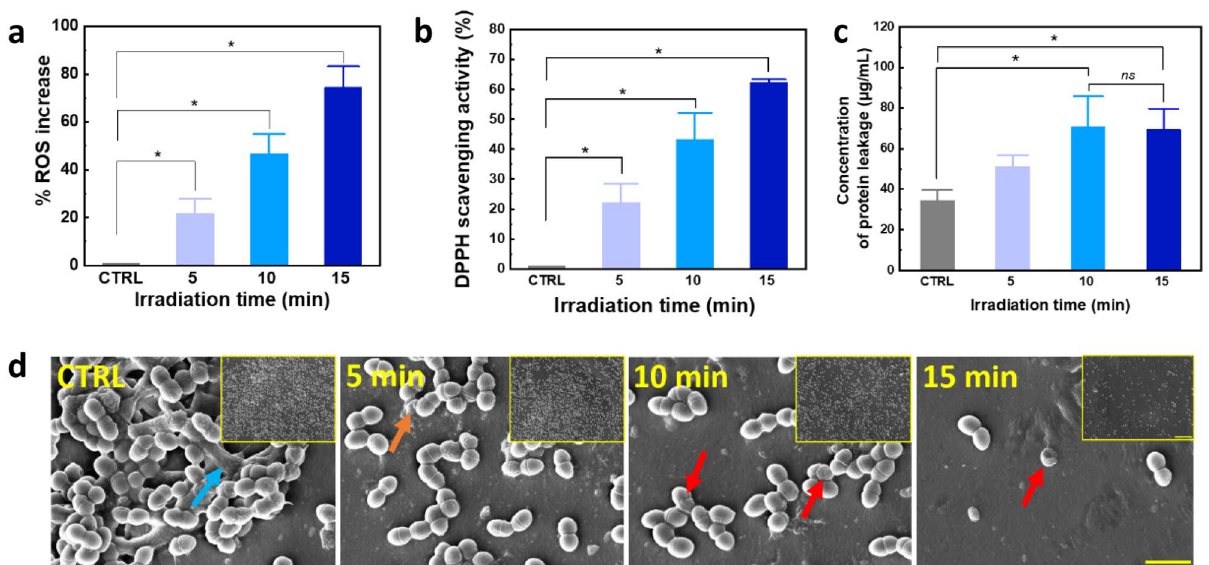
Figure 5. Optical inhibition effect of 405 nm laser light against S. aureus in urethral stent: ( a ) ROS generation during treatment, ( b ) DPPH scavenging activity, and ( c ) concentration of protein leakage using Lowry method ( * p < 0.05 and ** p < 0.001 vs. CTRL; ns = not significant; N = 5), and ( d ) SEM images of S. aureus after laser treatment (blue, orange, and red arrow represent thick biofilm, bacteria released from biofilm, and bacterial death with morphological damage (scale bar = 2 µm; 20 kX and scale bar of inlet = 20 µm; 2